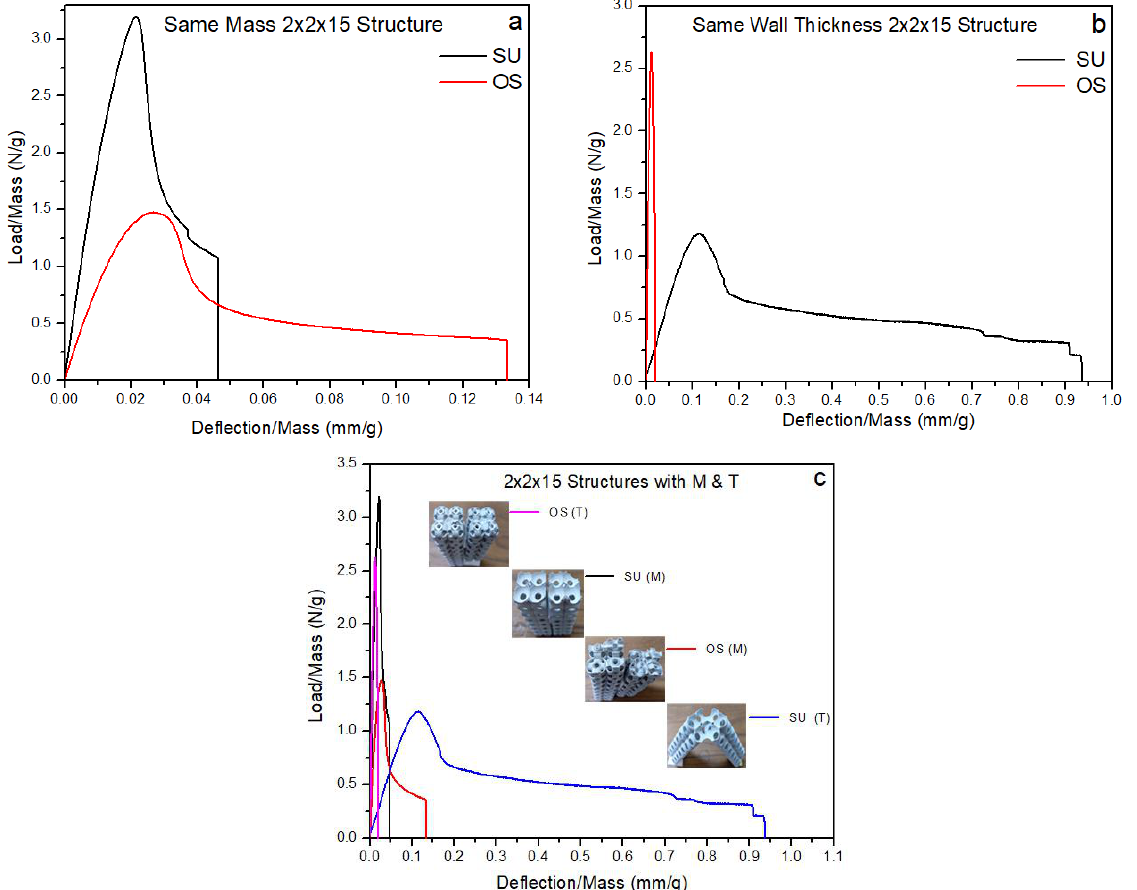
Figure 11. Specific strength of 2 × 2 × 15 lattice structures, ( a ) same density, ( b ) same wall thickness, ( c ) combined graph of both samples.